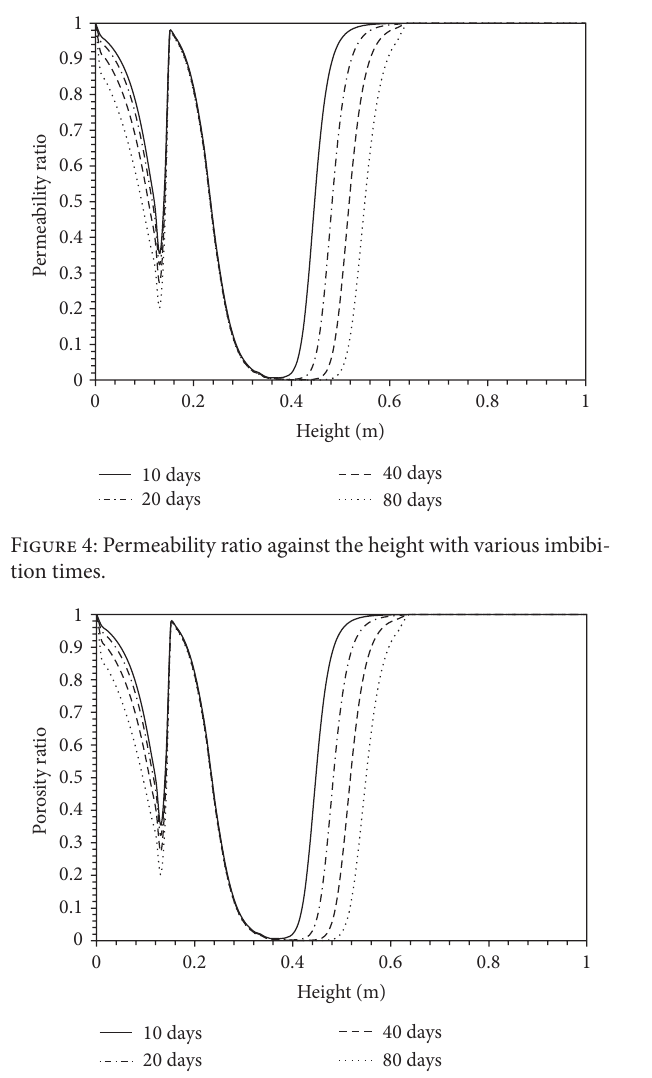
Figure 5: Porosity ratio against the height with various imbibition